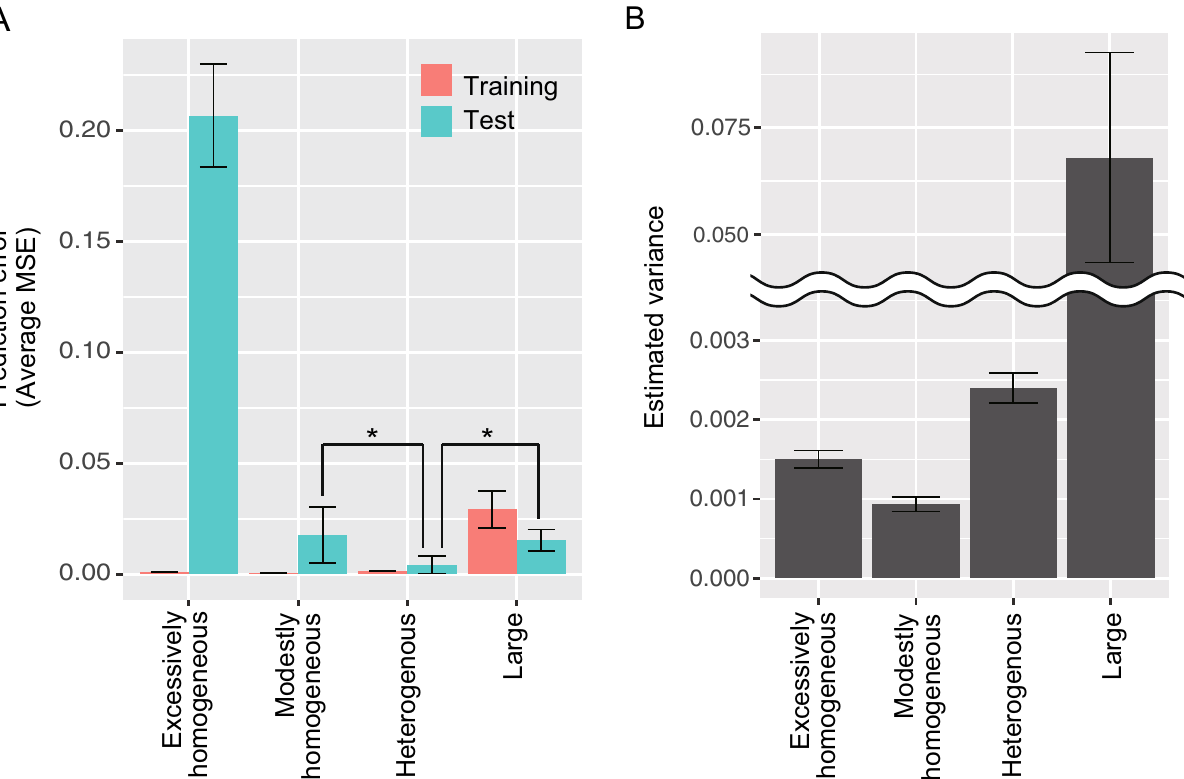
Figure 3. ( A ) Prediction error (average MSE) in various network models. The X axis indicates the network structures (detailed in Table 1) and the Y axis indicates the MSEs which are averaged over the sequence length, feature numbers, and sequence numbers. An enlarged view is shown in Supplementary Fig. S1A, and the results of various other networks are shown in Supplementary Figs. S1B, S2A. ( B ) Estimated variance in various network models. The estimated variances are averaged over the sequence length, feature numbers, and sequence numbers. MSE mean squared